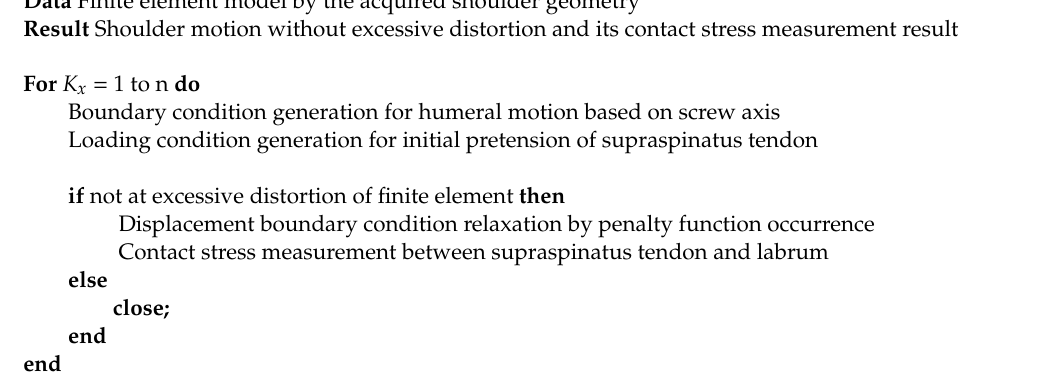
Table 2. Pseudo-code for FE simulations applied with the proposed